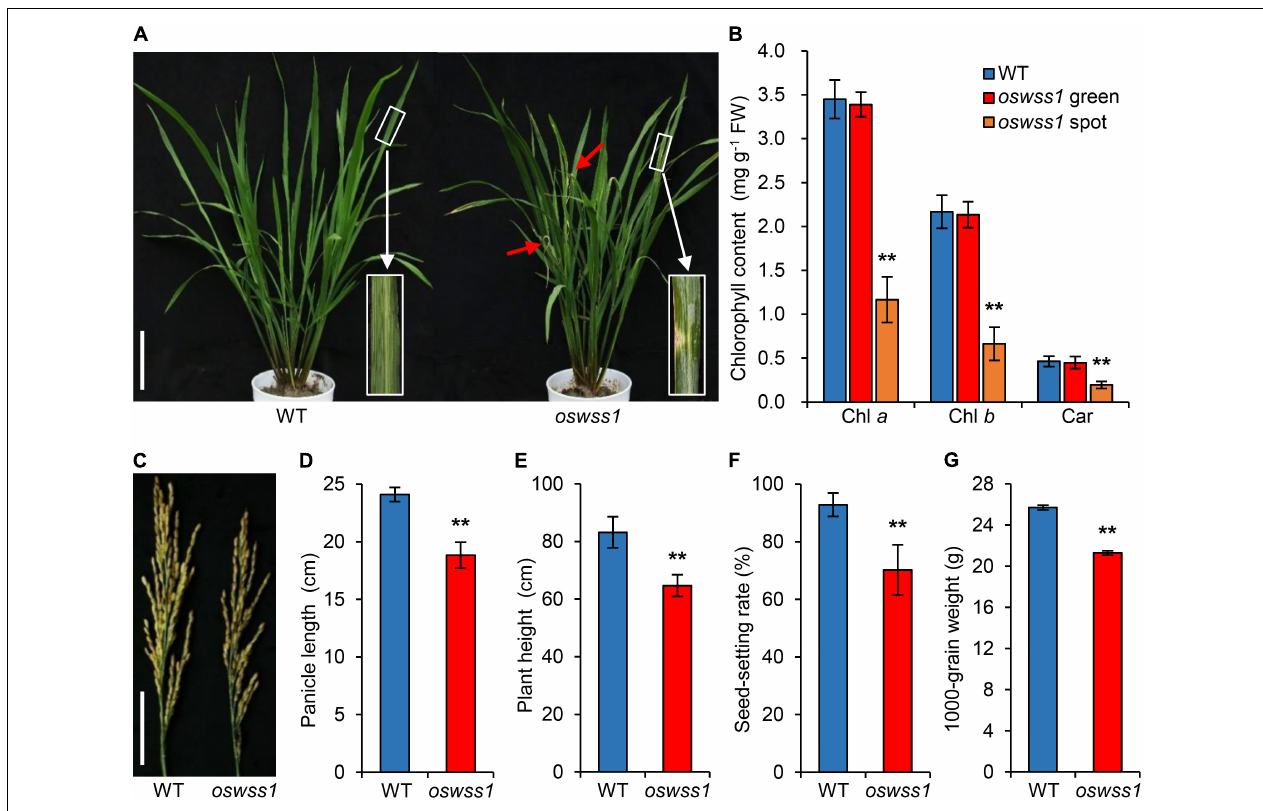
FIGURE 1 | Phenotype characterization and major agronomical traits of the rice oswss1 mutant. (A) Phenotype of wild type (WT) and oswss1 at the initial tillering stage (60 days after sowing, DAS). Inset shows a magnified view of a water-soaked spot of oswss1 leaves. Scale bar = 14 cm. (B) Comparison of chlorophyll content between WT and oswss1 at the initial tillering stage (60 DAS). Values are mean ± SD ( n = 6). (C) Panicle morphology comparison between WT and oswss1 at the heading stage (118 DAS). Scale bar = 6 cm. (D–G) Agronomic traits of WT and oswss1 plants. (D) Panicle length; (E) plant height; (F) seed-setting rate; (G) 1,000-grain weight. Values are mean ± SD ( n = 10). ** P < 0.01 (Student’s t